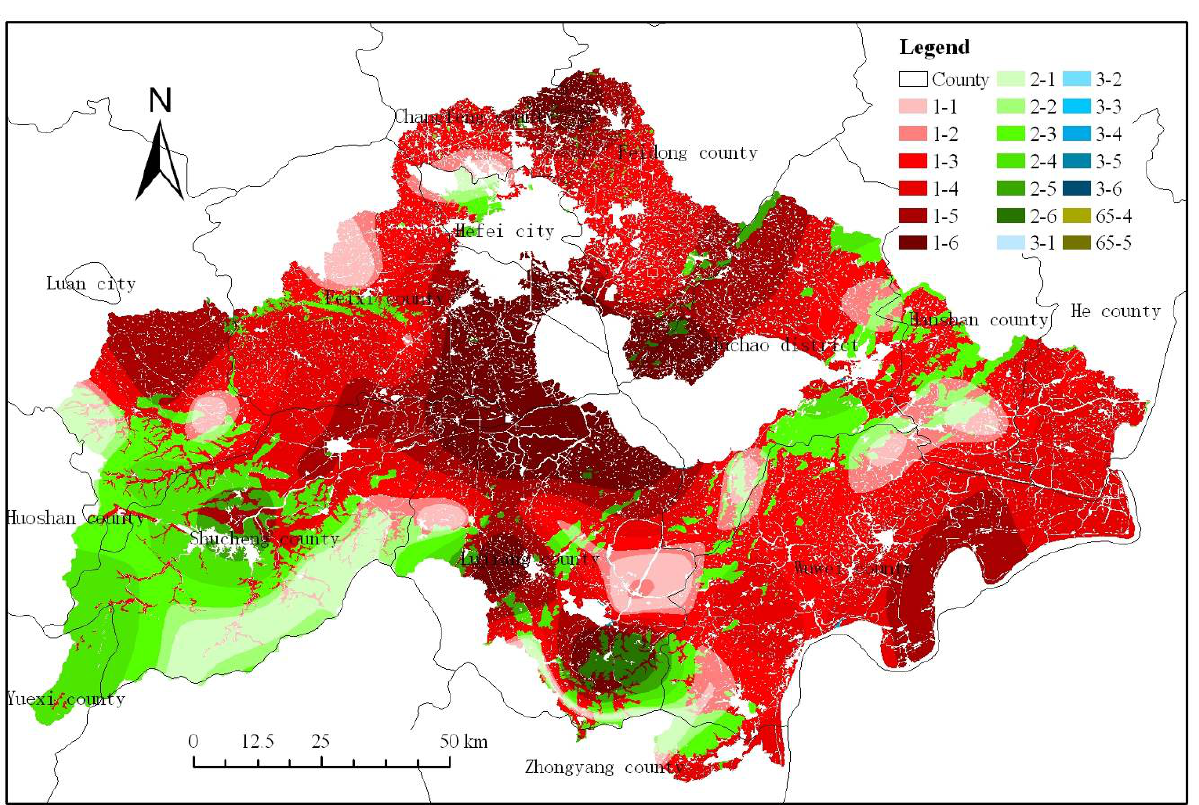
Figure 5. Spatial distribution of soil available phosphorus levels in different land use types. In the legend, the number before the symbol “-” represents the land use types and the 1, 2, 3 and 65 represents cultivated land, forest land, grassland, and bare land respectively, the number after the symbol “-” represents the soil available phosphorus levels as shown in Table